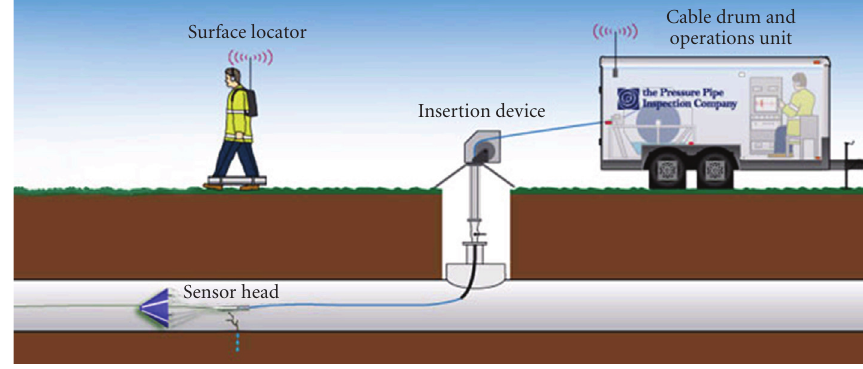
Figure 4: The Sahara system 46. Image Courtesy of the Pressure Pipe Inspection